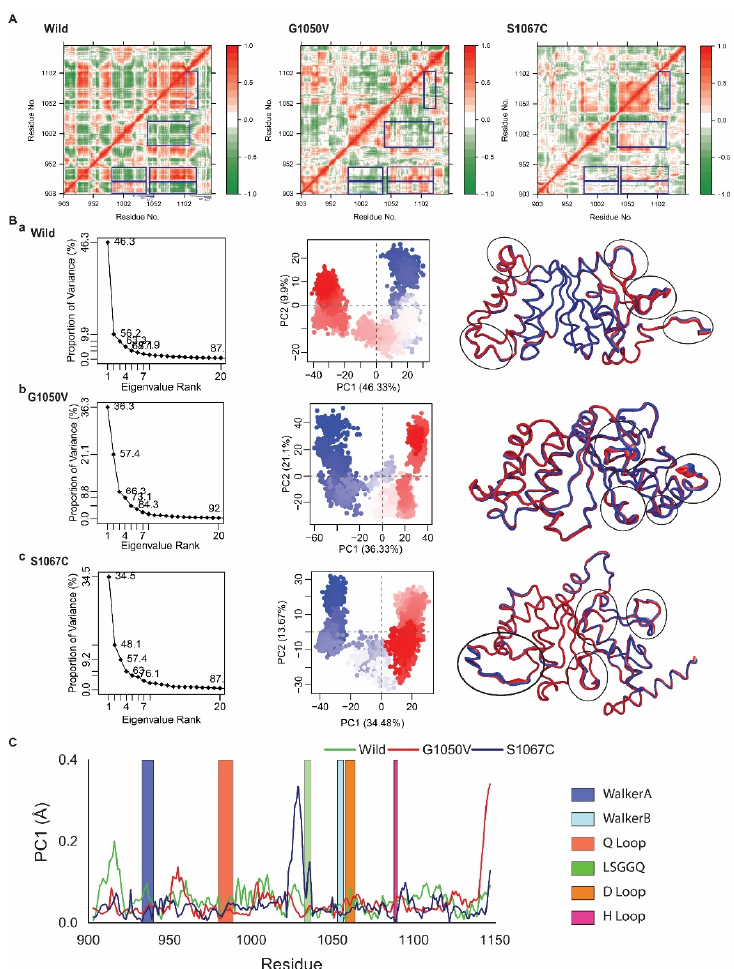
Figure 5. Effects of variants on protein dynamics movement. ( A ) Representative correlated dynamic cross-correlation maps (DCCMs) generated from simulated trajectories of wild-type, G1050V, and S1067C. Here the residue-residue cross-correlations are visualized in a two-dimensional heatmap with a colored codded representation of green to white to red. The residual movement that is correlated is represented as a red color, while green color indicates a negative correlation, and white means random motions. ( B ) Principle Component Analysis (PCA) on the simulated trajectories of wild-type, G1050V, and S1067C. Here, the projection of simulated trajectories of an individual system, including wild-type ( a ), G1050V ( b ), and S1067C ( c ), is represented in the left panel, where the middle section shows the conformational distribution of each protein captured on in the first two principal components. Here, each dot describes the protein conformation, where simulation time is represented by a color-coded scale from blue to white to red. The right panel shows total atomic displacements of the protein for PCA1, which is visualized in the tube model, indicating protein flexible region by broader tube. ( C ) Residue-wise mobility plot for PC1, where green, red, and dark blue describe wild, G1050V, and S1067C,